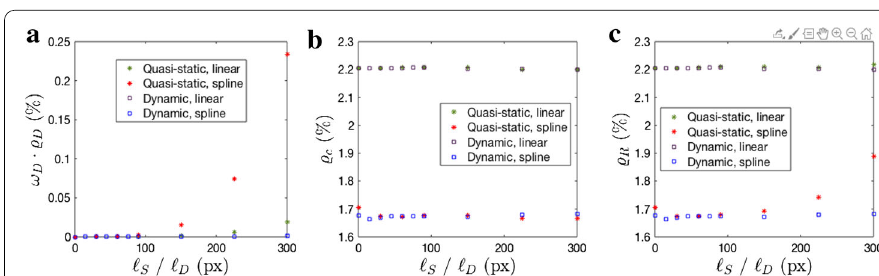
Fig. 10 Change of w D (cid:2) D , (cid:2) C and (cid:2) R (in percentage of the dynamic range) with the regularization length. Two different gray level interpolation schemes were tested. These results prove the efficiency of the dynamic regularization in comparison with the static regularization